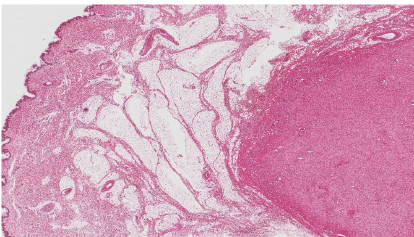
Figure 2: On histopathological examination ( × 10;HE), the tumor was located in the subcutaneous region. There is an uninvolved segment between the tumor and overlying squamous epithelium. The boundary between the tumor and adjacent tissue was well